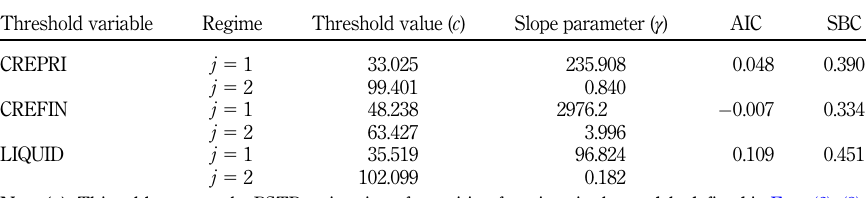
Table 3. PSTR estimates